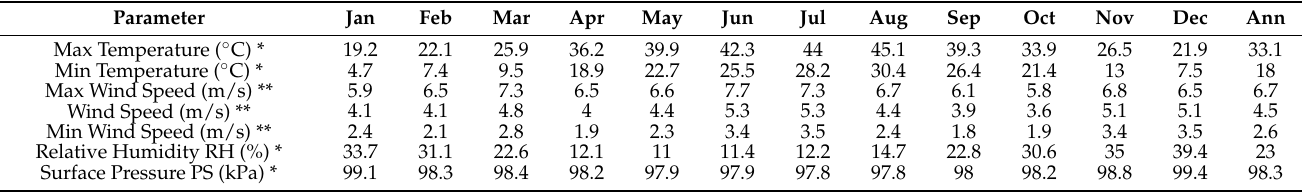
Table 19. Meteorological parameter for Kaberten from 1 January 2015–31 December 2015. Parameter